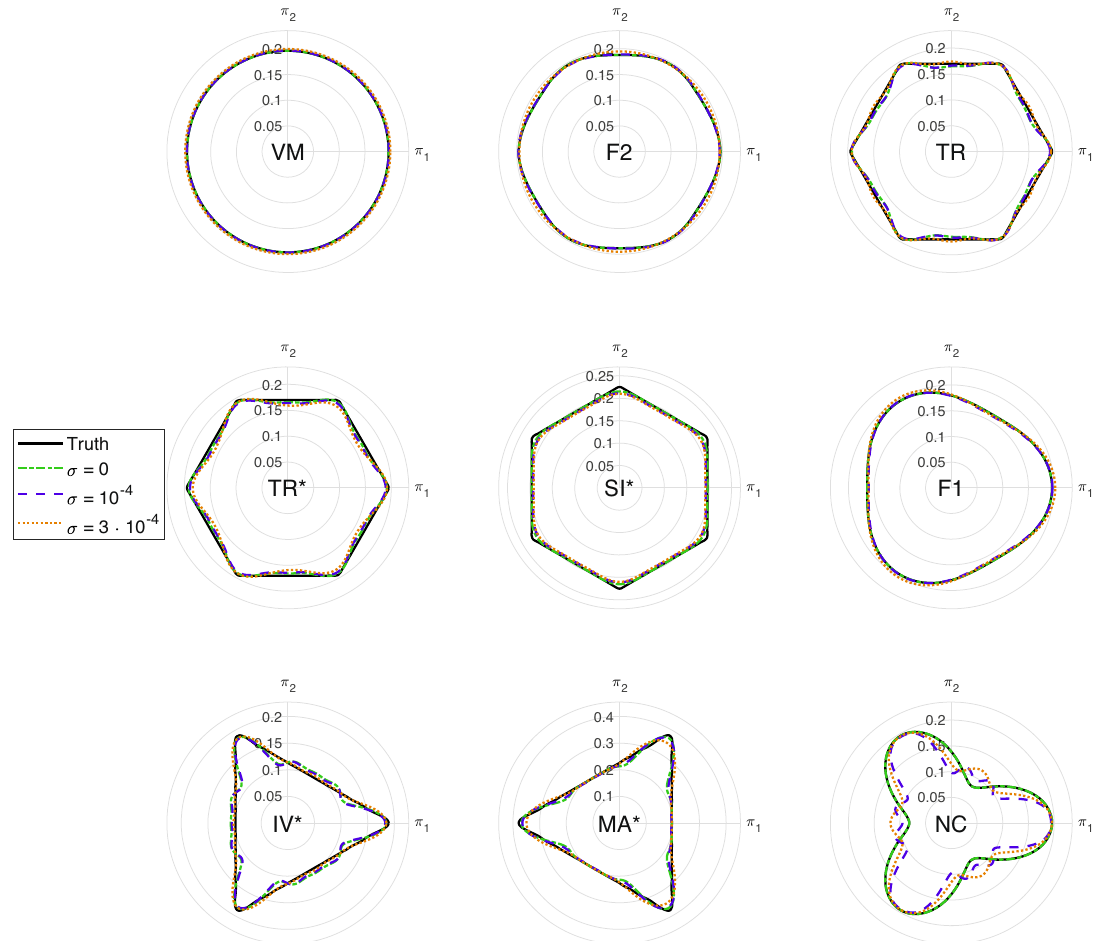
Fig. 3 Yield surface plots of the (true) hidden and discovered plasticity models for different noise levels σ (in mm). Yield surfaces are shown for γ = 0.1, which is an upper limit of the accumulated plastic multiplier in the considered data sets. Coordinates π 1 , π 2 are in kN mm − 2 . For the tension-compression symmetric models, the symmetry axes are indicated by black dotted lines.